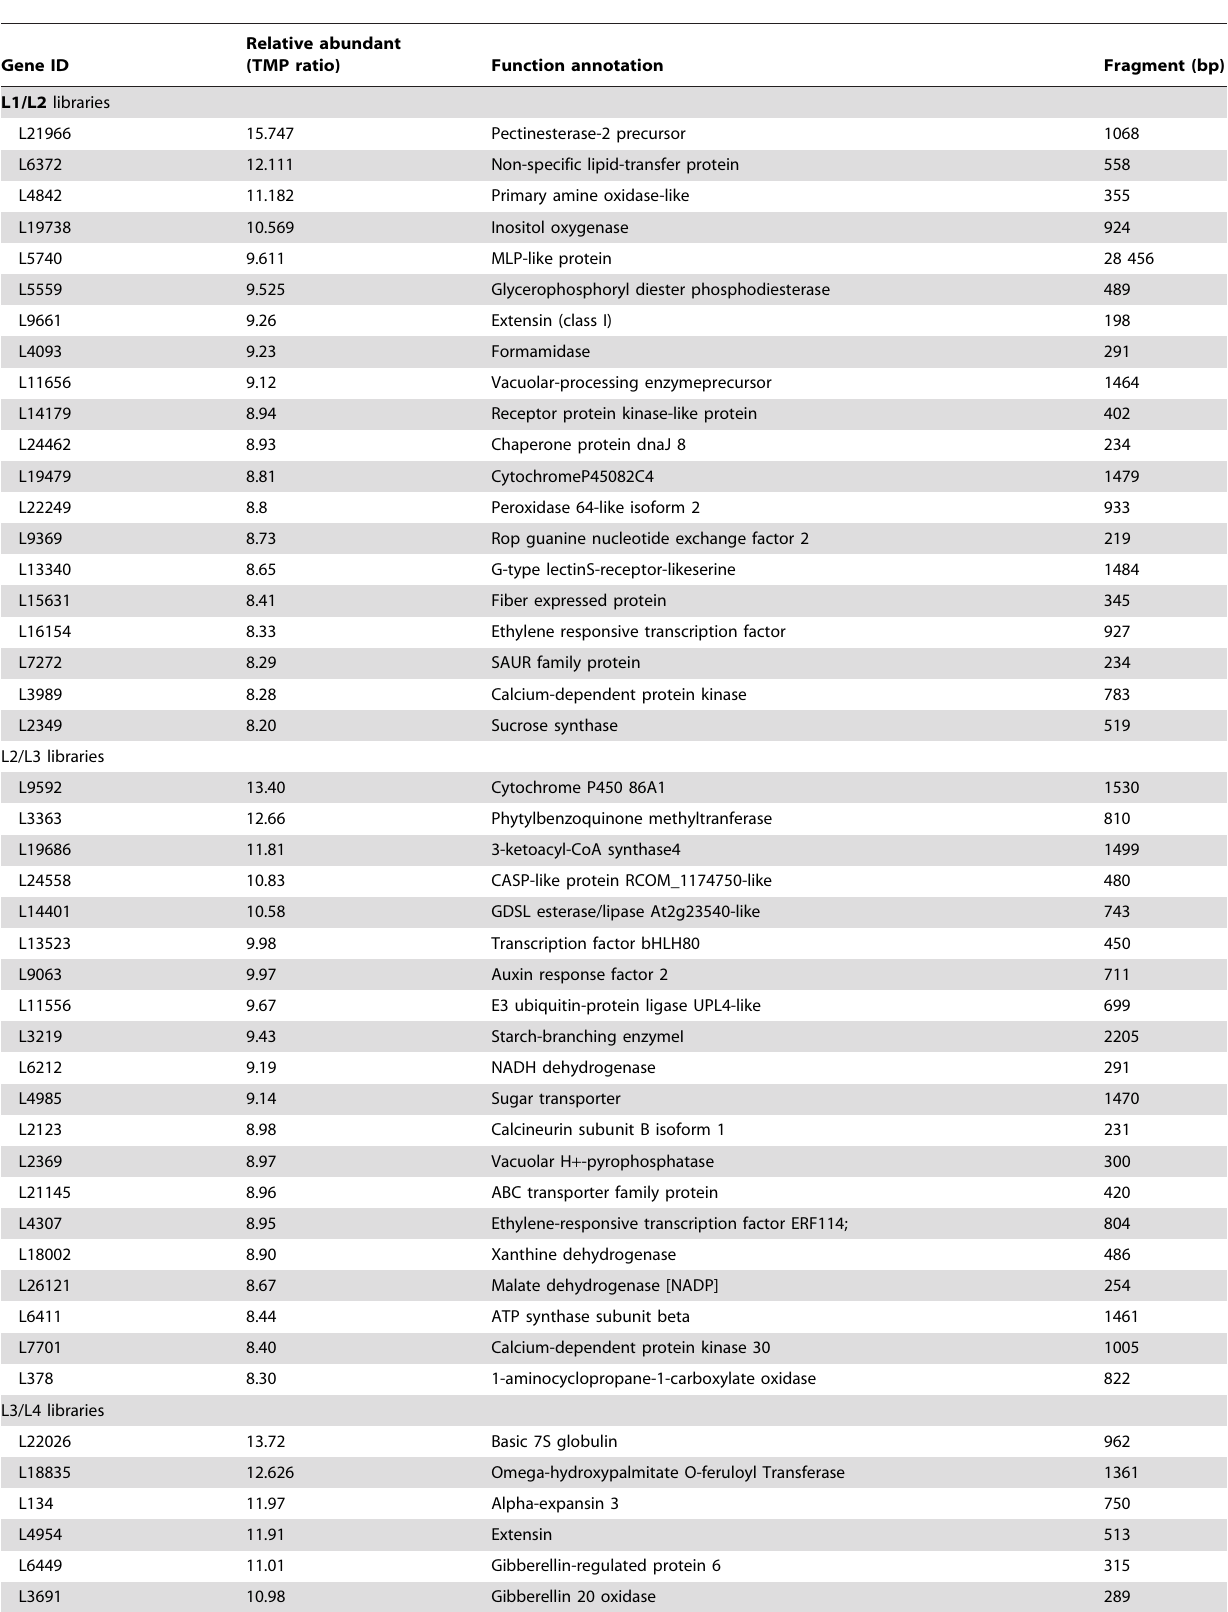
Table 4. 20 most differentially expressed annotated genes in L1/L2, L2/L3, and L3/L4 libraries based on expressed tag frequency.